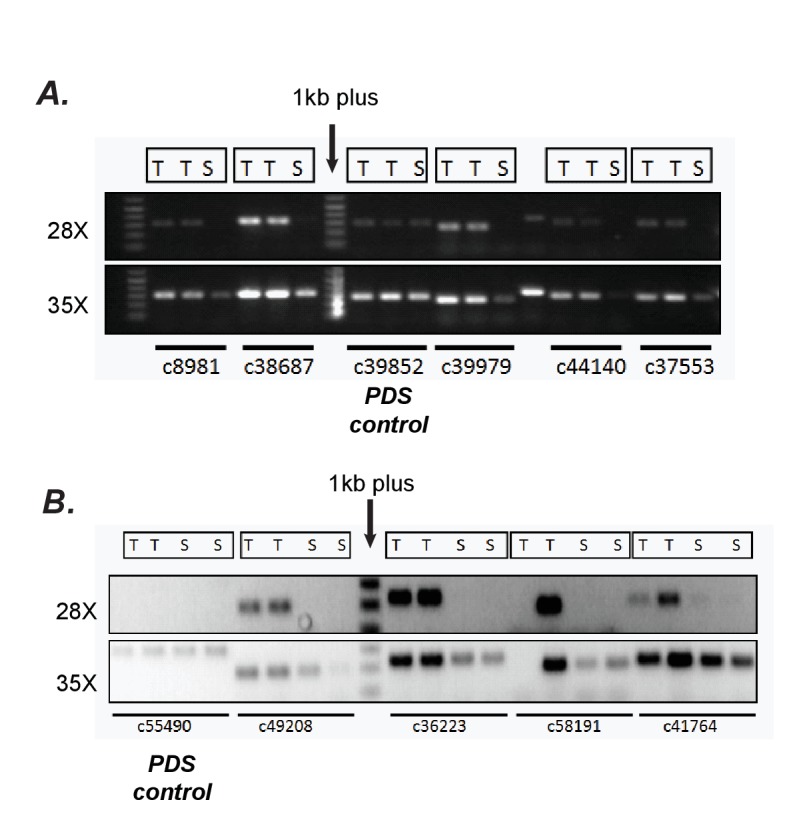
Confirmation of differential expression results from RNA-seq using semi-quantitative RT-PCR.(A, B) Verification of trichome high expression of certain transcripts using semi-quantitative RT-PCR in S.quitoense (A) and Salpiglossis (B). The comparisons between Trichome (T) and Shaved stem (S) tissues involved using the same amount of starting cDNA, stopping the reactions after 28 or 35 cycles of PCR and running them on an agarose gel. Phytoene desaturase (PDS) which was not estimated to be differentially expressed based on RSEM/EBSeq analysis was used as control.